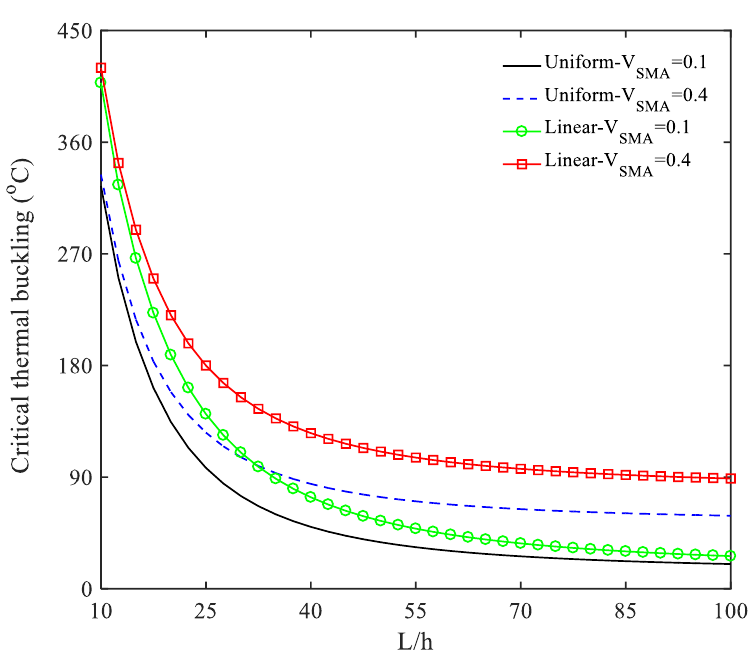
Figure 6. Variation of the critical thermal loading vs. L / h for two types of temperature distribution and different values of V SMA ( n = 1, h c / h = 0.8 and ε 0 = 2%).